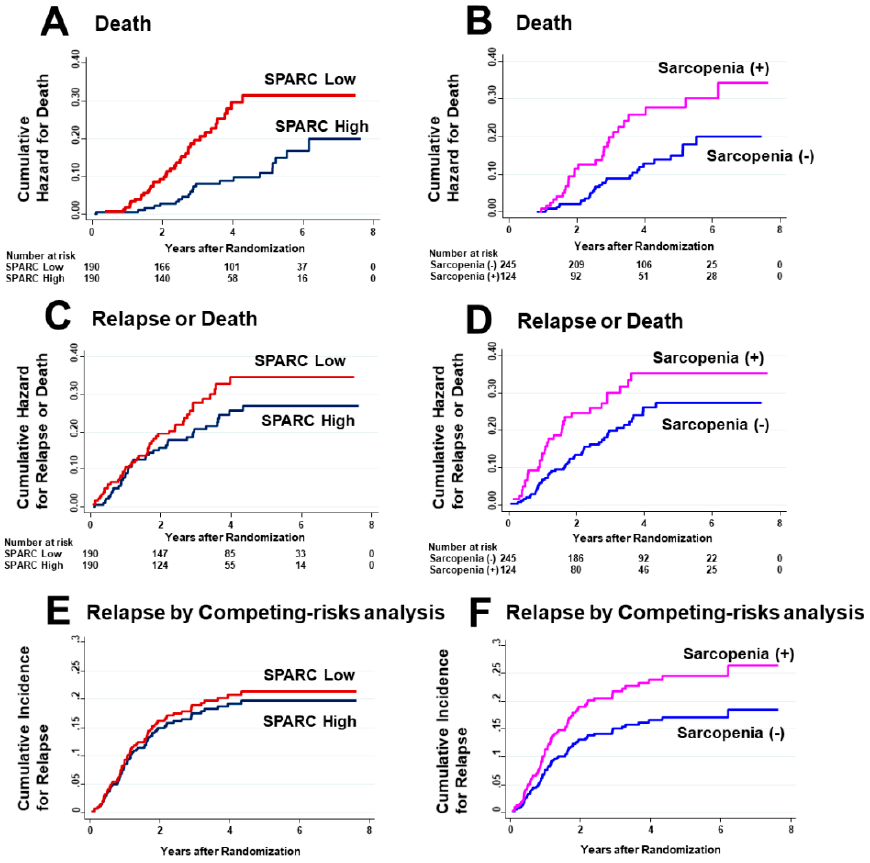
Figure 6. Cumulative hazard curves for outcomes. Cumulative hazard curves for death stratified by SPARC levels ( A ) and absence or presence of sarcopenia ( B ). Cumulative hazard curves for relapse or death stratified by SPARC levels ( C ) and absence or presence of sarcopenia ( D ). Cumulative hazard curves for relapse stratified by SPARC levels ( E ) and absence or presence of sarcopenia ( F ).